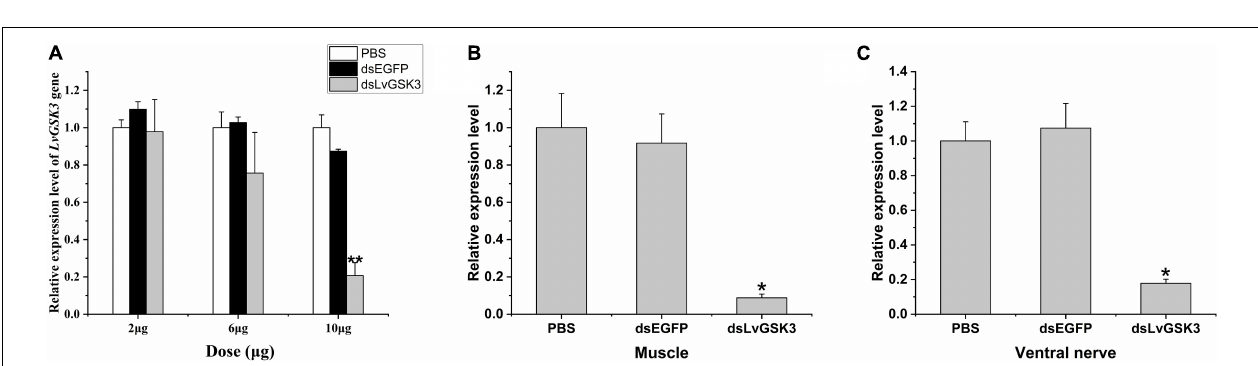
FIGURE 6 | The relative expression levels of different treatments. (A) The silencing efficiency of LvGSK3 injected with different dosages of dsRNA. (B) Relative expression level of LvGSK3 after RNAi in muscle. (C) Relative expression level of LvGSK3 after RNAi in ventral nerve. The expression of target gene was detected by real-time PCR and normalized to the 18S rRNA as the internal reference. The results were based on three independent biological replications and showed at mean values ± SD. Significant differences of the gene expression levels between three treatments are shown as ** p < 0.01 and * p < 0.05.